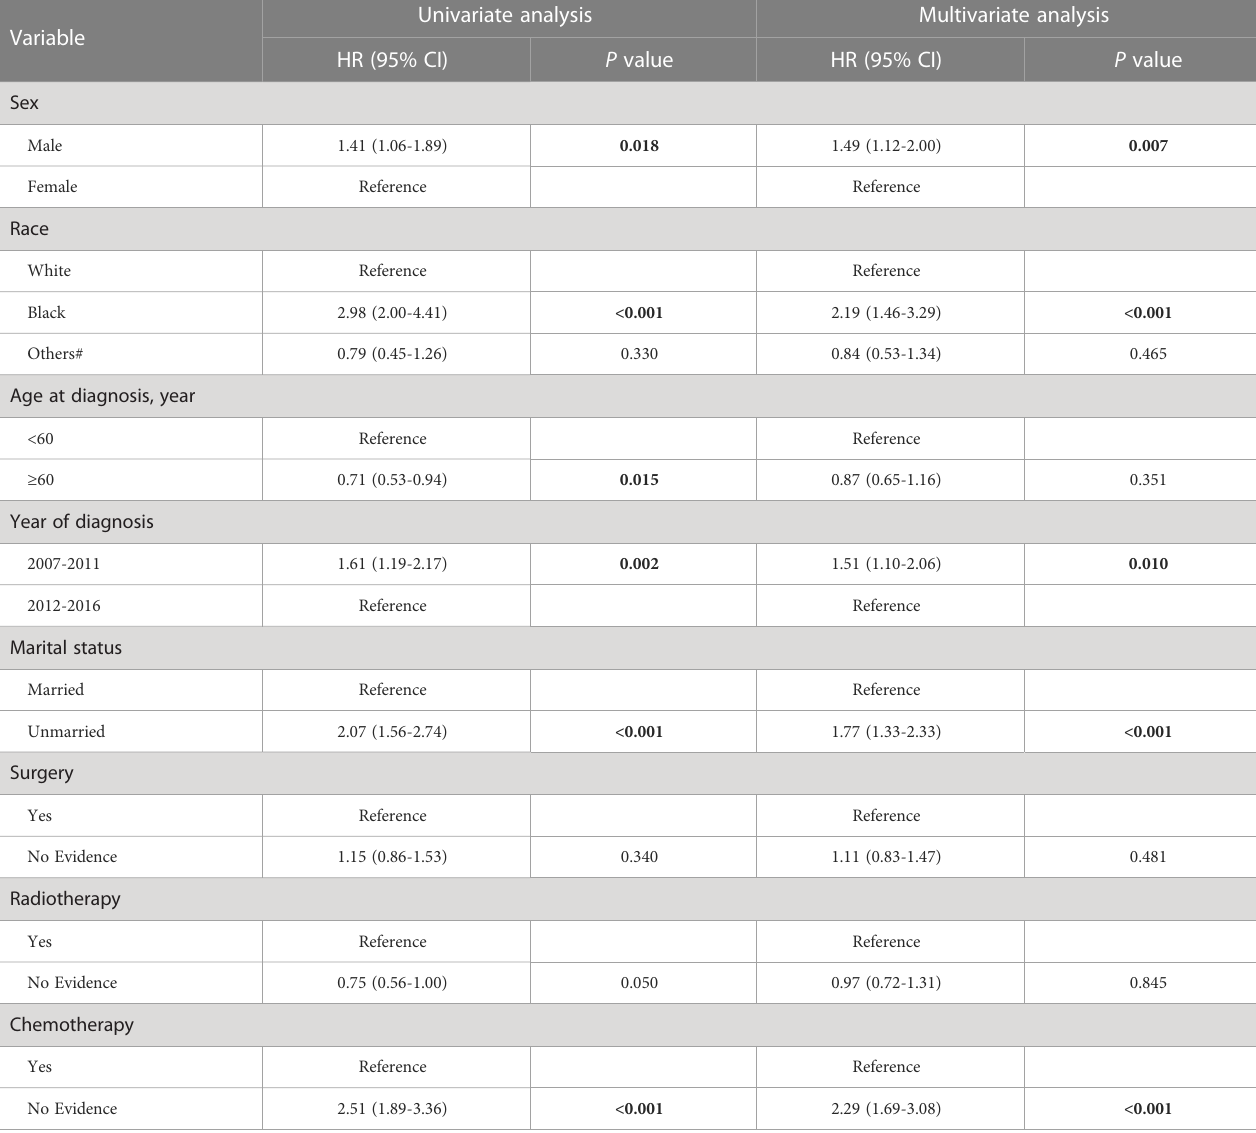
TABLE 5 Competing risk regression analyses of risk factors for non-cancer-speci fi c survival in PCNS-DLBCL.